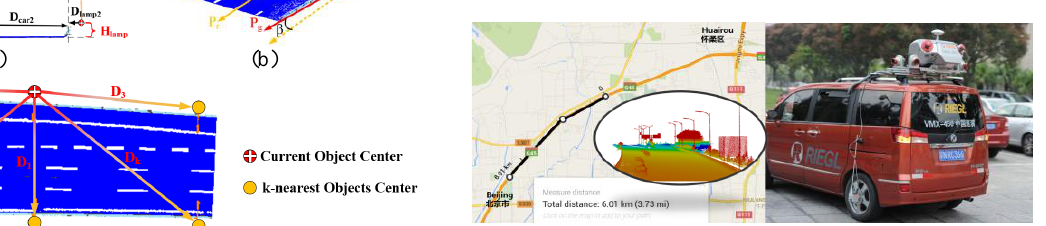
Figure 8. Overview of the MLS system and point cloud